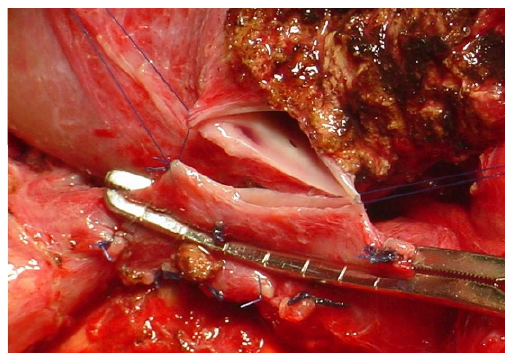
Figure 2 - View of the end-to-side anastomosis between the hepatic vein of the graft and the inferior vena cava. The inferior vena cava is partially clamped.